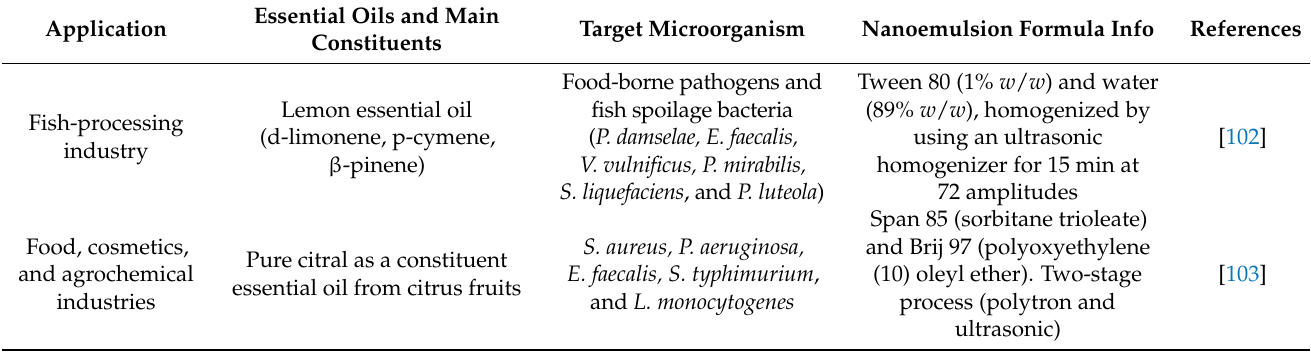
Table 3. Applications of nanoemulsions in the cosmetics and food industries as preservation